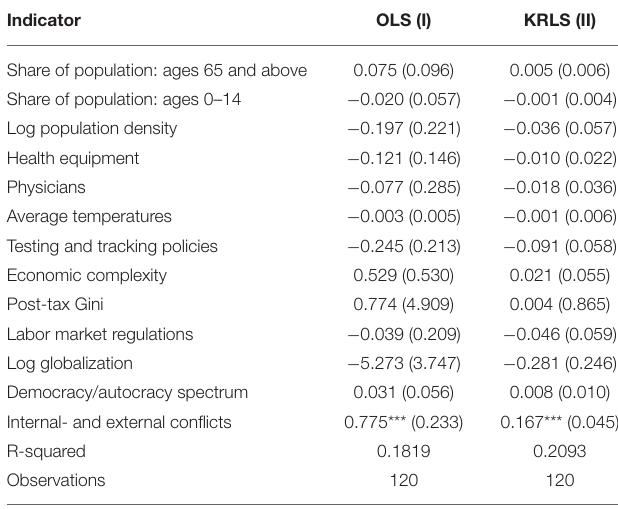
TABLE 2 | Results of Ordinary Least Squares (OLS) and Kernel-based Regularized Least Squares (KRLS) estimations (all countries). Indicator